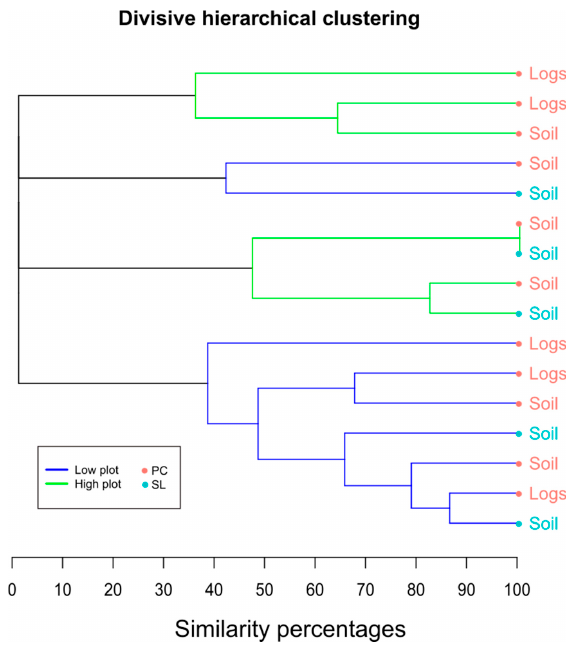
Figure 3. Two-dimensional non-metric multidimensional scaling ordination using Bray–Curtis distance of belowground macroathropod communities under two different treatments and microhabitats (stress coefficient = 0.088). The solid circles indicate the centroid for each dead-wood treatment by microhabitat combination, and the other symbols indicate each treatment replicate. Polygons are the groups for the salvage logging (blue) and the partial cut (red) treatment. The differences between the treatments and microhabitats were not significant.